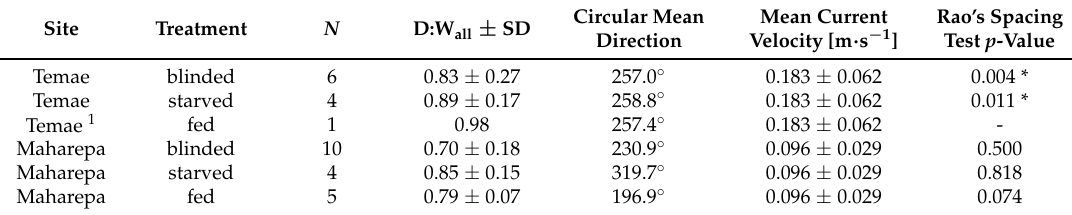
Table 2. Mean movement direction of Acanthaster cf. solaris after 3 h, test for a preferred direction (Rao’s spacing test) and D:W all value at two sites with respective water current strengths. Note that the circular mean direction is not very meaningful when there is no preferred direction in the seastars movement (when Rao’s spacing test is not significant). * Refers to significant test p < 0.05.